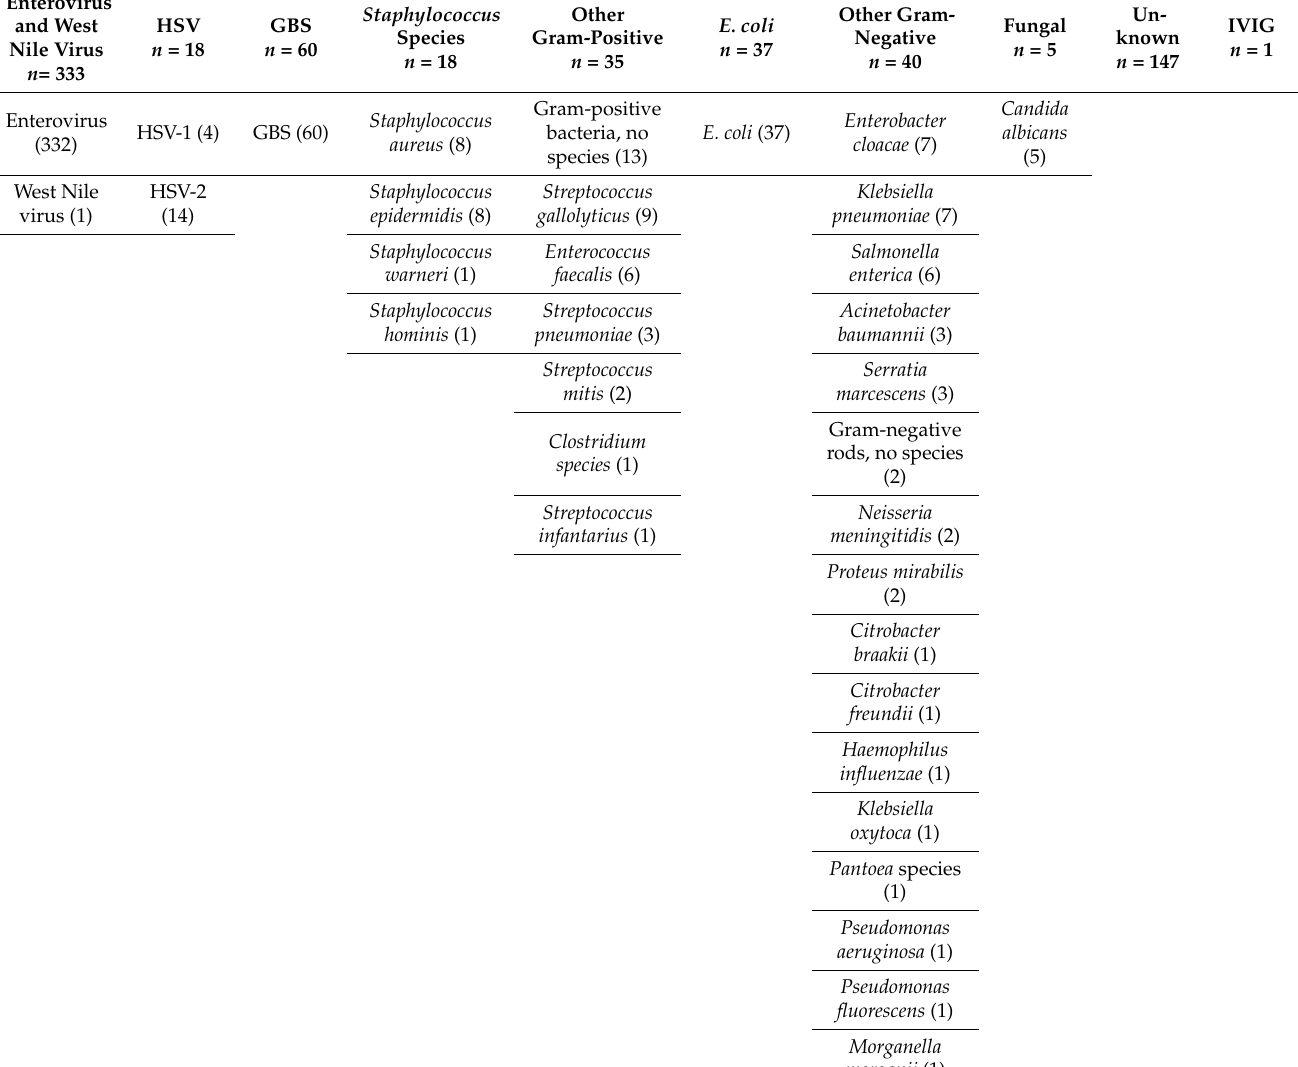
Table 2. Subclassifications of causes of infant meningitis, Houston, TX